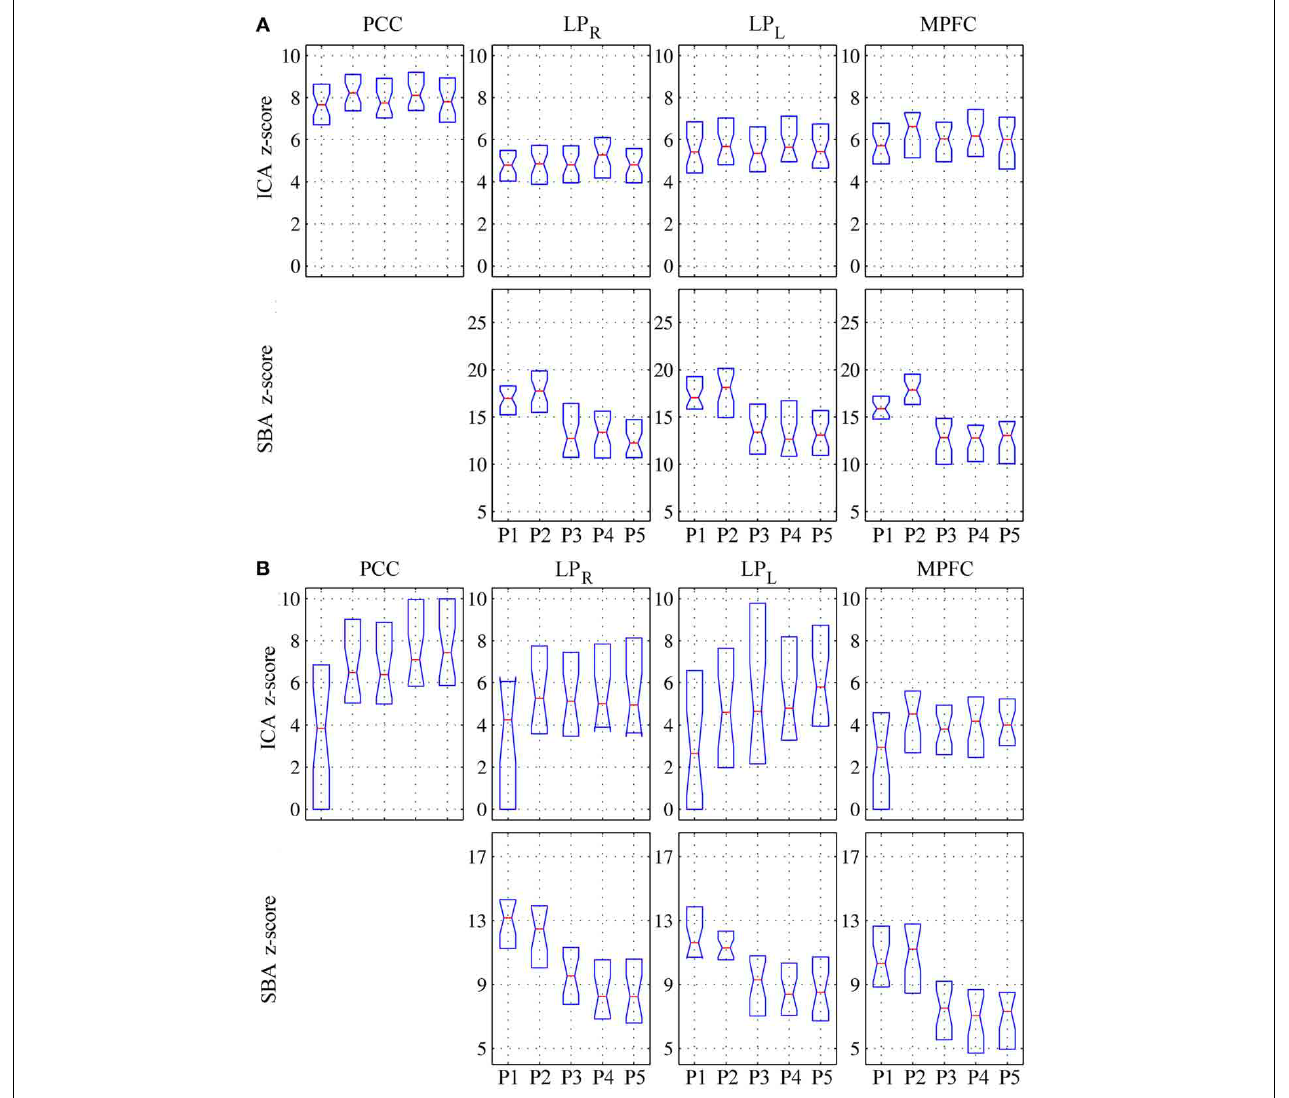
FIGURE 3 | Peak z -scores for activity within the four main DMN nodes for (A) healthy controls and (B) patients. Top row: DMN component extracted by ICA; bottom row: correlation maps computed using precuneus seeds (SBA). As preprocessing steps were added to the